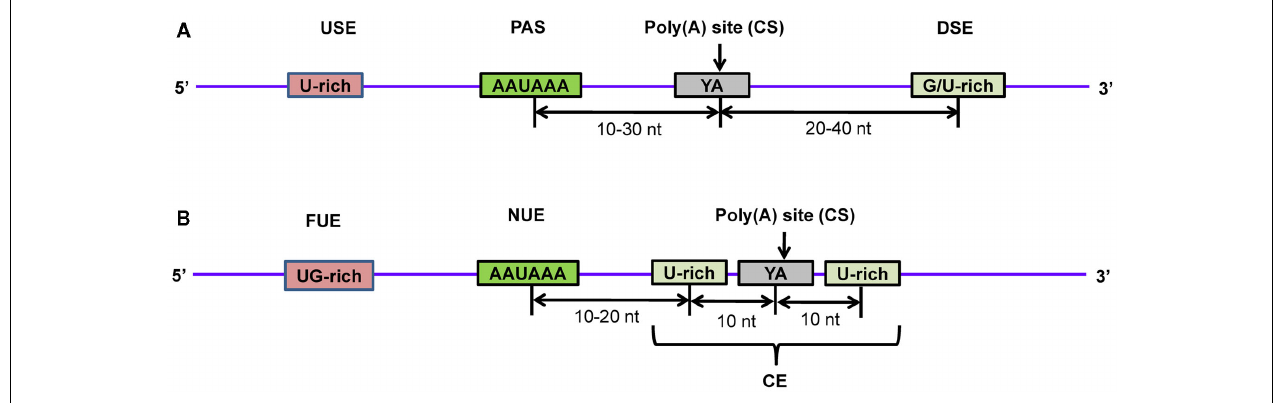
poly(A) site and poly(A) polymerase carries out polymerization at the newly formed 3 (cid:2) -end to generate the mature mRNA. USE, upstream element; PAS, poly(A) signal; CS, cleavage site; DSE, downstream element; FUE, far upstream element; NUE, near upstream element; CE, cleavage element.